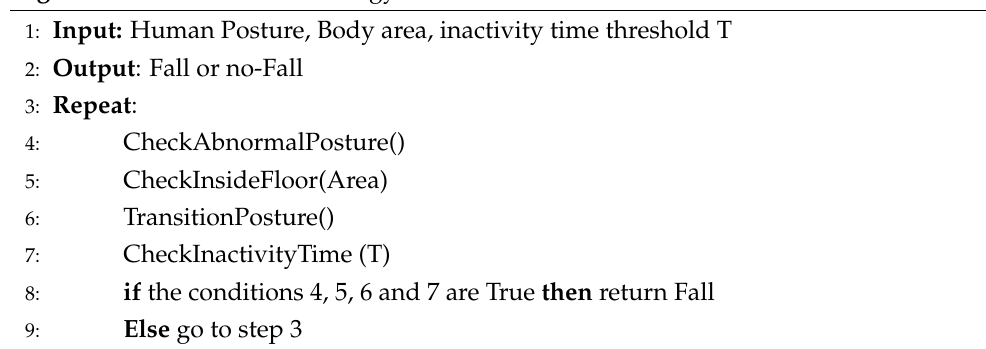
Algorithm 2 Fall detection strategy